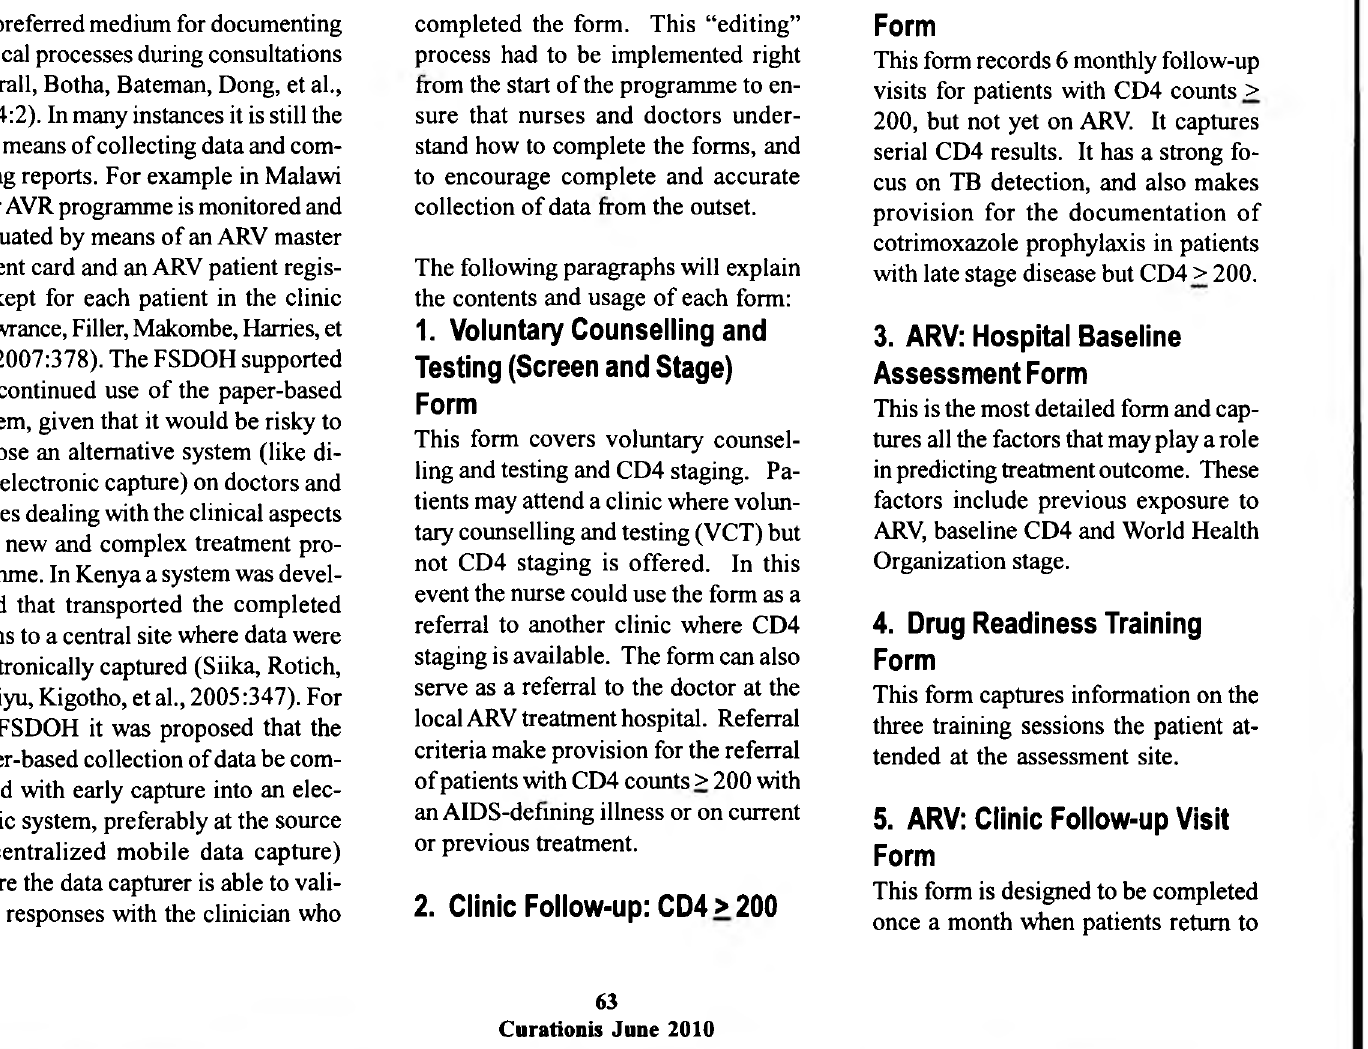
Figure 1: ARV Forms and Form